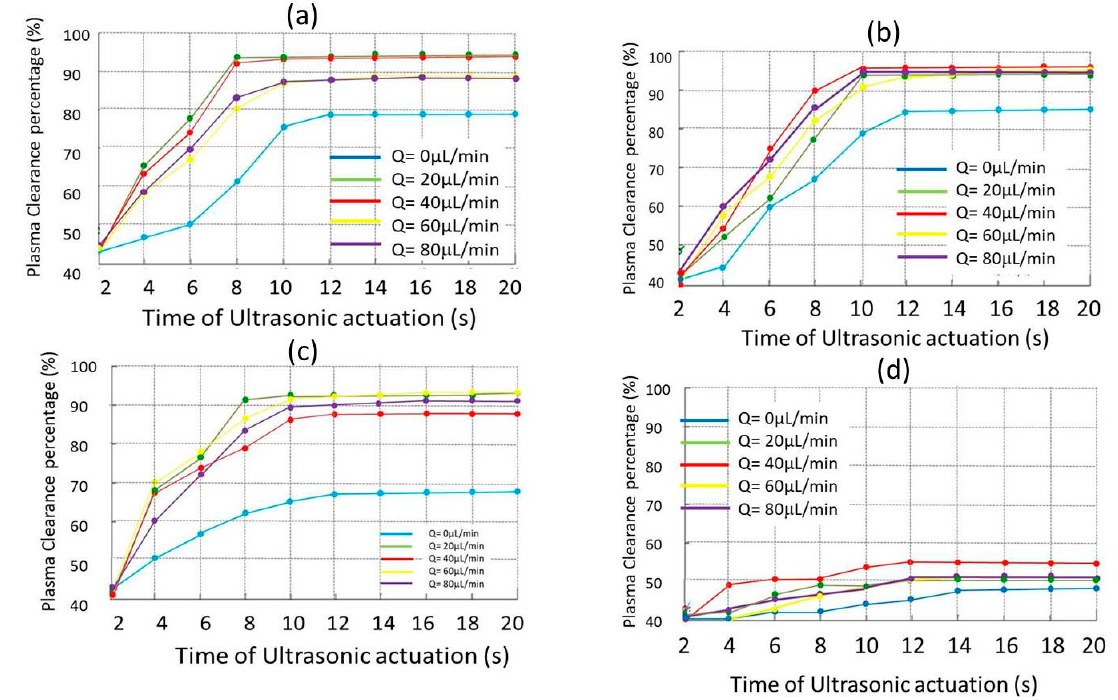
Figure 4. ( a ) Clearance blood plasma vs. time of acoustic treatment at different flow rate conditions for blood dilution samples: ( a ) 1:20; ( b ) 1:10; ( c ) 1:5 and ( d ) 1:2 respectively.